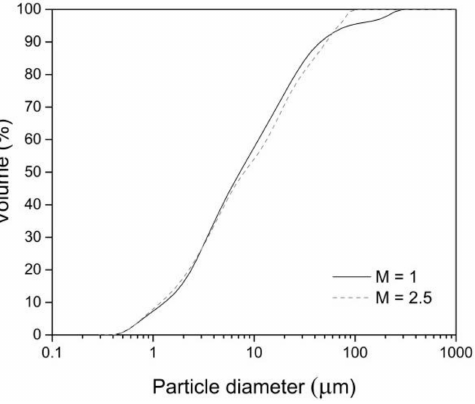
Figure 1. Particle size distributions of prepared cement mixtures with two molar ratios (M). Table 2. Phase composition of unhydrated cements with M = 1 and M = 2.5 in wt. % determined with Rietveld